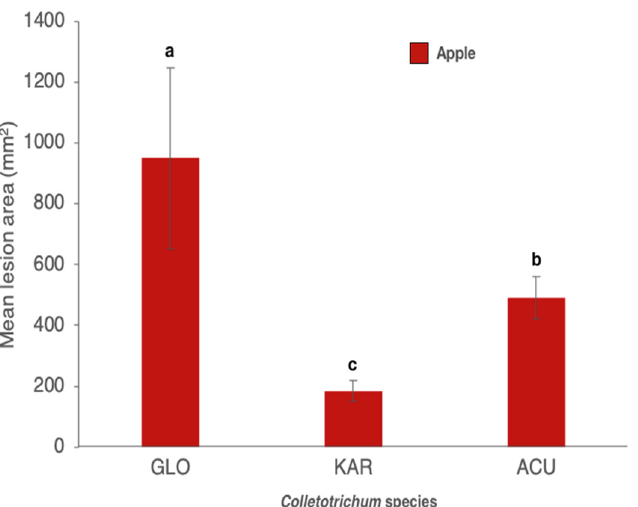
Figure 5. Mean area (± SD) of necrotic lesions (mm 2 ) induced by Colletotrichum gloeosporioides (GLO), C. karstii (KAR) and C. acutatum (ACU) isolates on wound inoculated apples, seven d.p.i. Values sharing same letters are not statistically different according to Tukey’s honestly significant difference (HSD) test ( p ≤